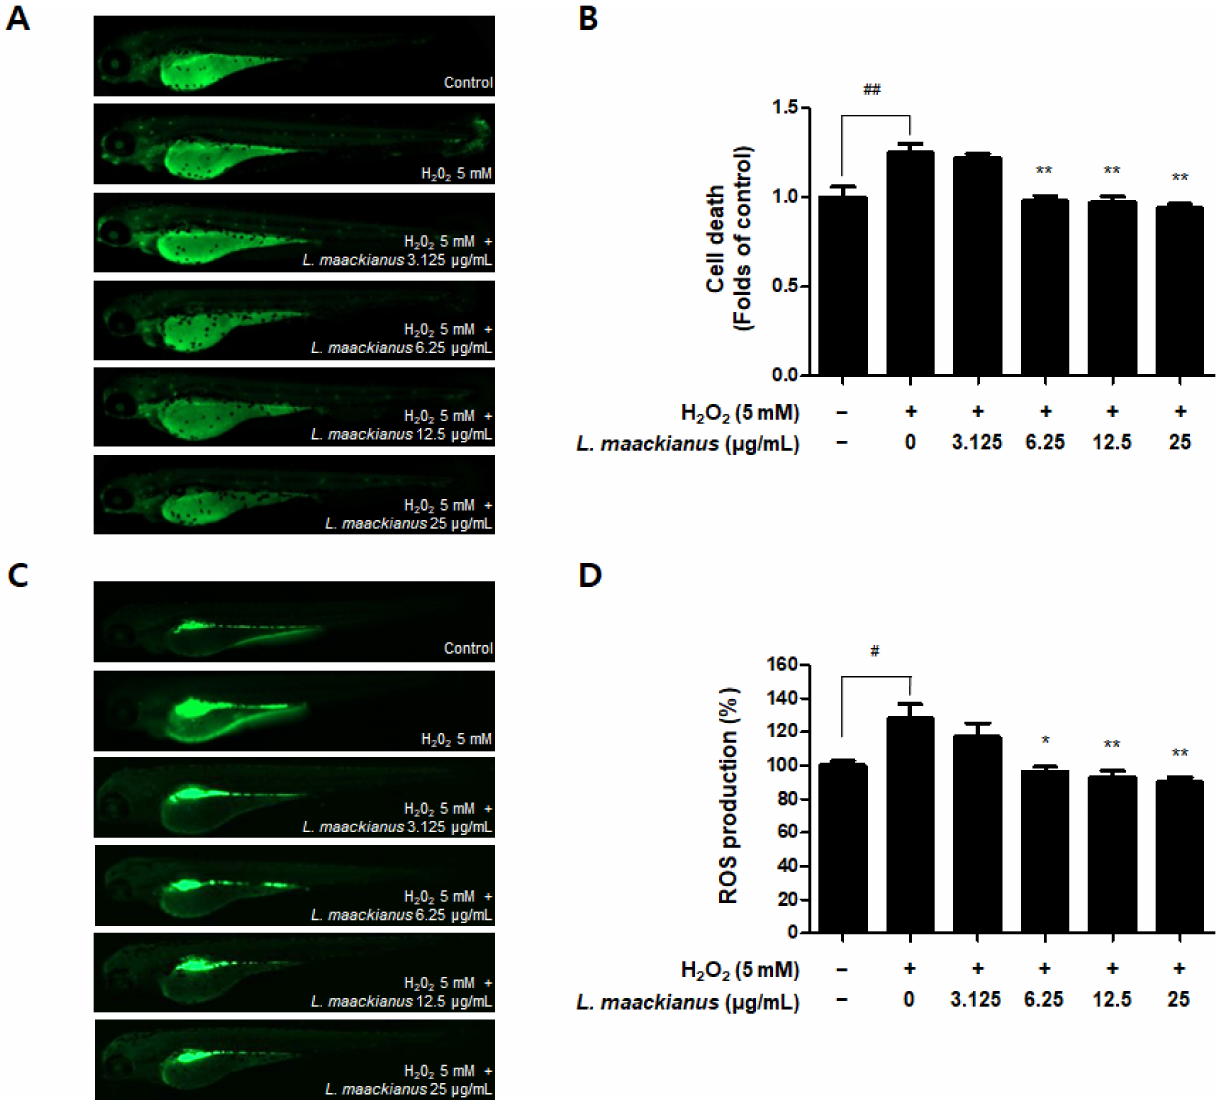
Figure 8. Cytoprotective effect ( A , B ) and reactive oxygen species (ROS) generation inhibitory effect ( C , D ) of L. maackianus MeOH extract in a H 2 O 2 -treated zebrafish model. Results were assessed after 7